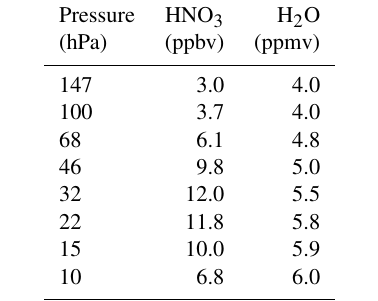
Table A1. HNO 3 and H 2 O values for PSC threshold calculation. Pressure values are rounded to nearest integer.